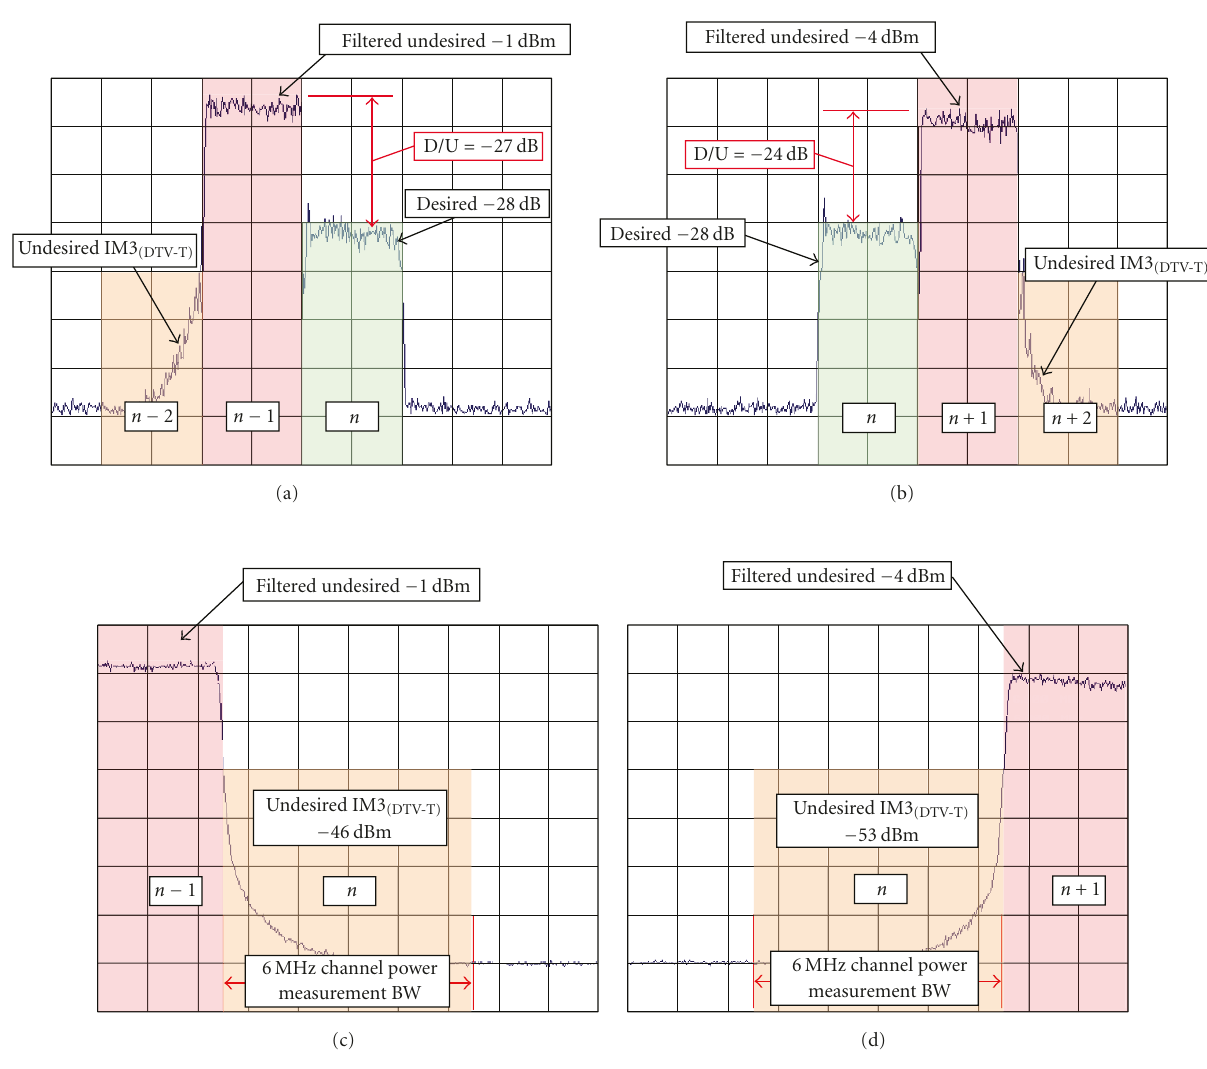
Figure 10: (a) n = − 28dBm; undesired signal at n − 1; minimum IM 3(DTV-T) configuration (b) n = − 28 dBm; undesired signal at n + 1; minimum IM 3(DTV-T) configuration (c) IM 3(DTV-T) level present in desired channel n . Undesired signal at n − 1; Minimum IM